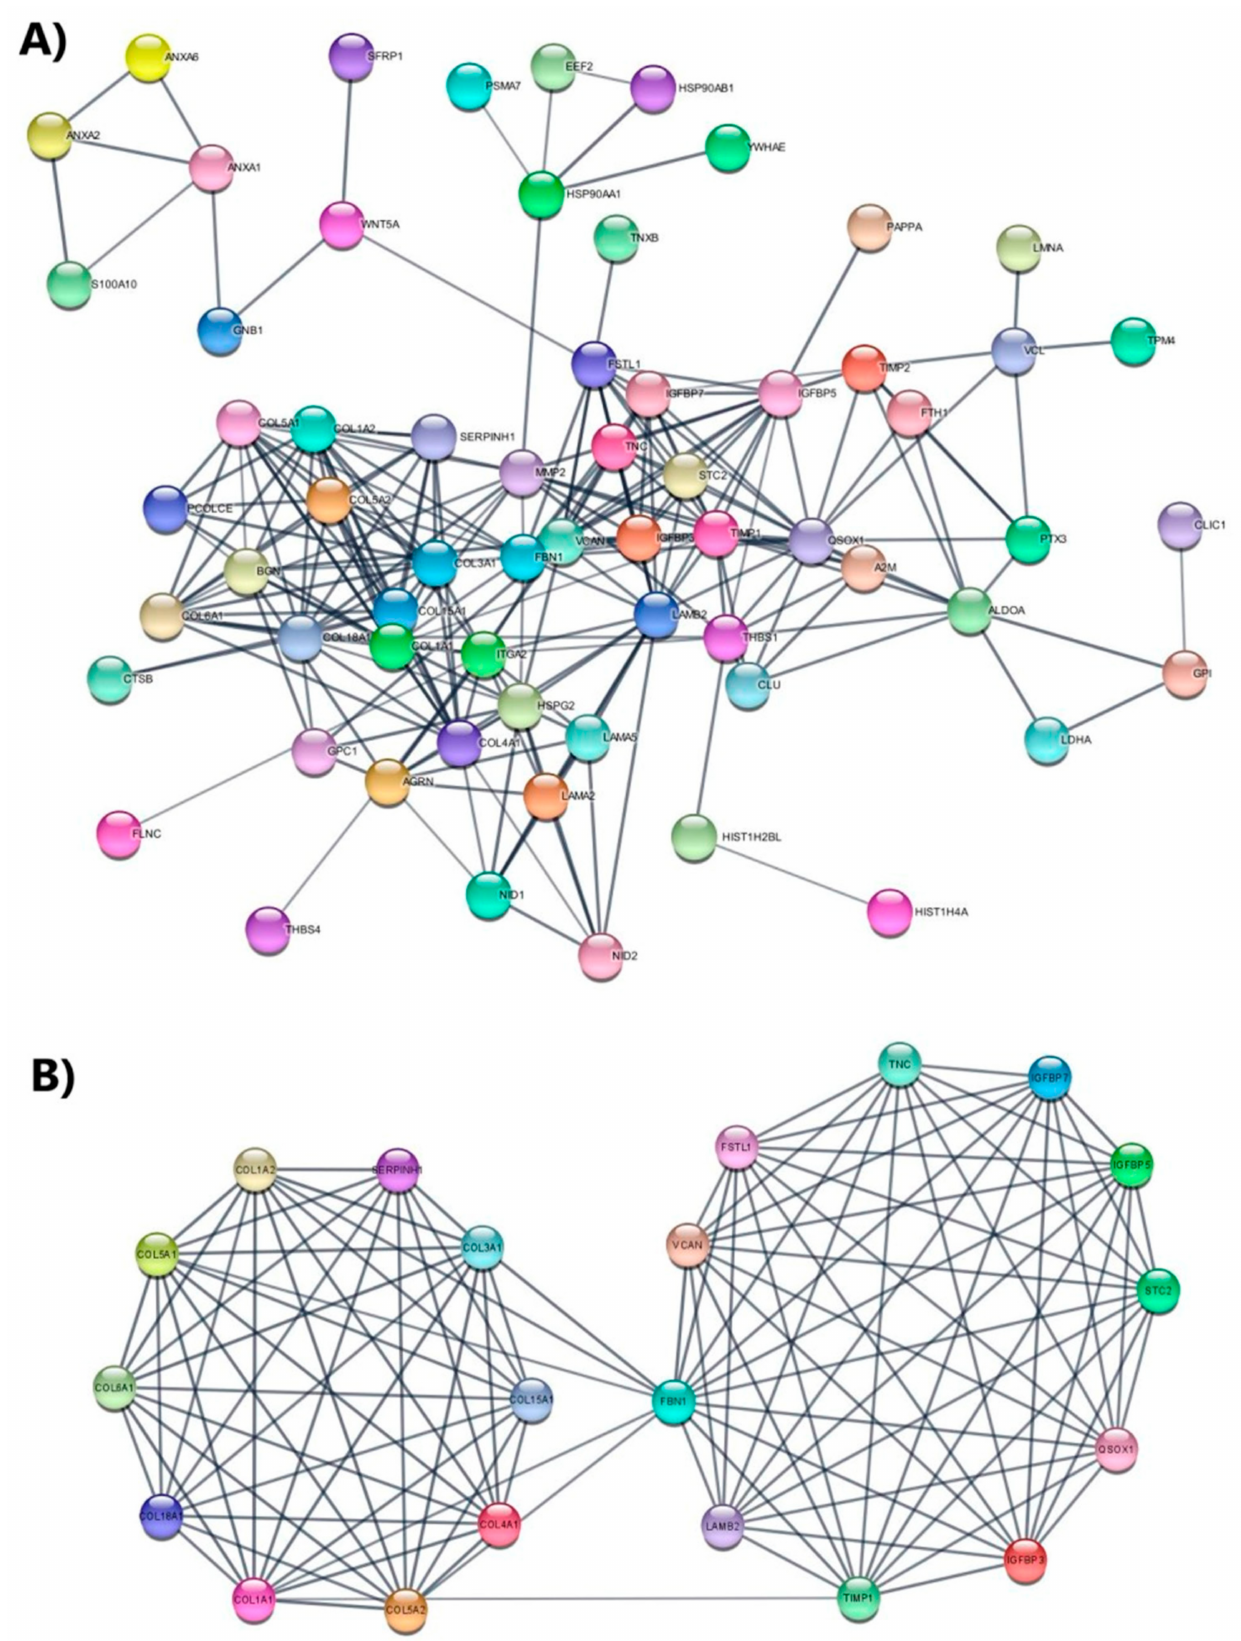
Figure 6. Protein–protein interaction regulatory network of differentially expressed proteins. ( A ) Differentially expressed proteins were combined to construct a regulatory network using both STRING and Cytoscape software to visualize